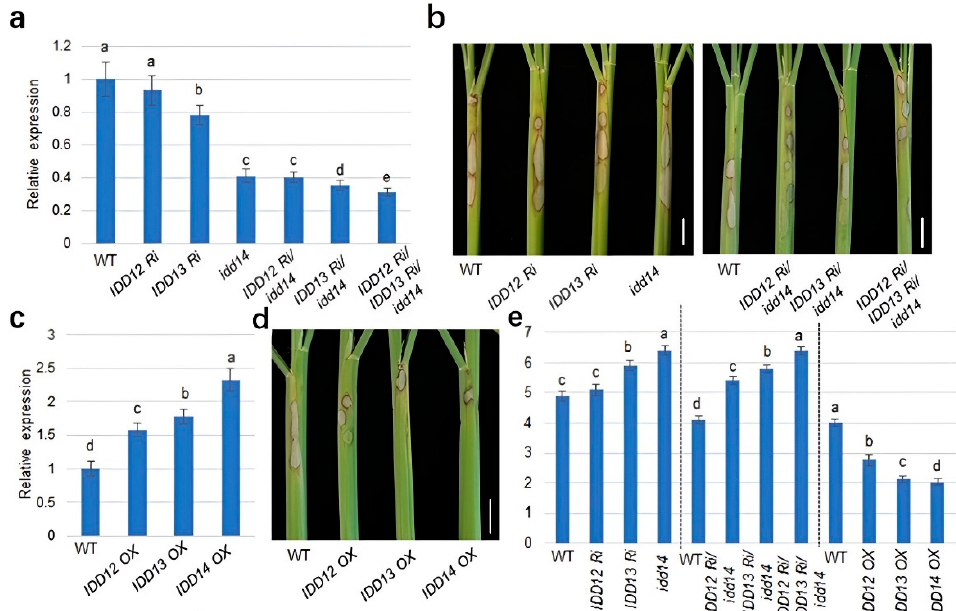
Figure 4. Rice ShB resistance is positively regulated by IDD12, IDD13 , and IDD14 : ( a ) MDPK expression level in wild-type, IDD12 RNAi , IDD13 RNAi , idd14 , IDD12 RNAi/idd14 , IDD13 RNAi/idd14 , and IDD12 RNAi/IDD13 RNAi/idd14 plants. Ubiquitin was used as reference gene to normalize gene expression levels. The error bars mean ± SE ( n = 3); ( b ) the response of wild-type, IDD12 RNAi , IDD13 RNAi , idd14 , IDD12 RNAi/idd14 , IDD13 RNAi/idd14 , and IDD12 RNAi/IDD13 RNAi/idd14 plants to R. solani AG1-IA were analyzed; ( c ) MDPK expression level in wild-type, IDD12 OX , IDD13 OX , and IDD14 OX plants. Ubiquitin was used as reference gene to normalize gene expression levels. The error bars mean ± SE ( n = 3); ( d ) wild-type, IDD12 OX , IDD13 OX , and IDD14 OX plants were inoculated with R. solani AG1-IA; ( e ) the lesion lengths from the plants shown in ( b , d ) were calculated. Data indicate average ± standard error (SE) ( n > 8). Bonferroni’s multiple comparison test, was used for the calculation of comparisons between different groups. Letter a–e in the figure indicate significant differences at p < 0.05.